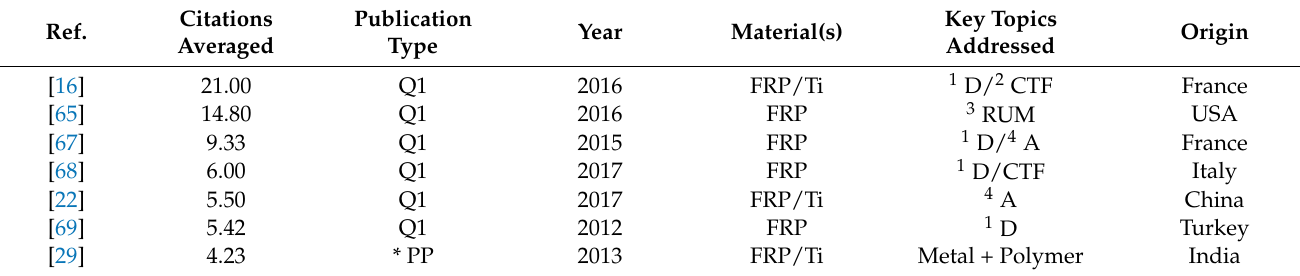
Table 10. Summary of studies including drilling process listed by number of citations, listed by average number of citations considering the number of years the article has been published.